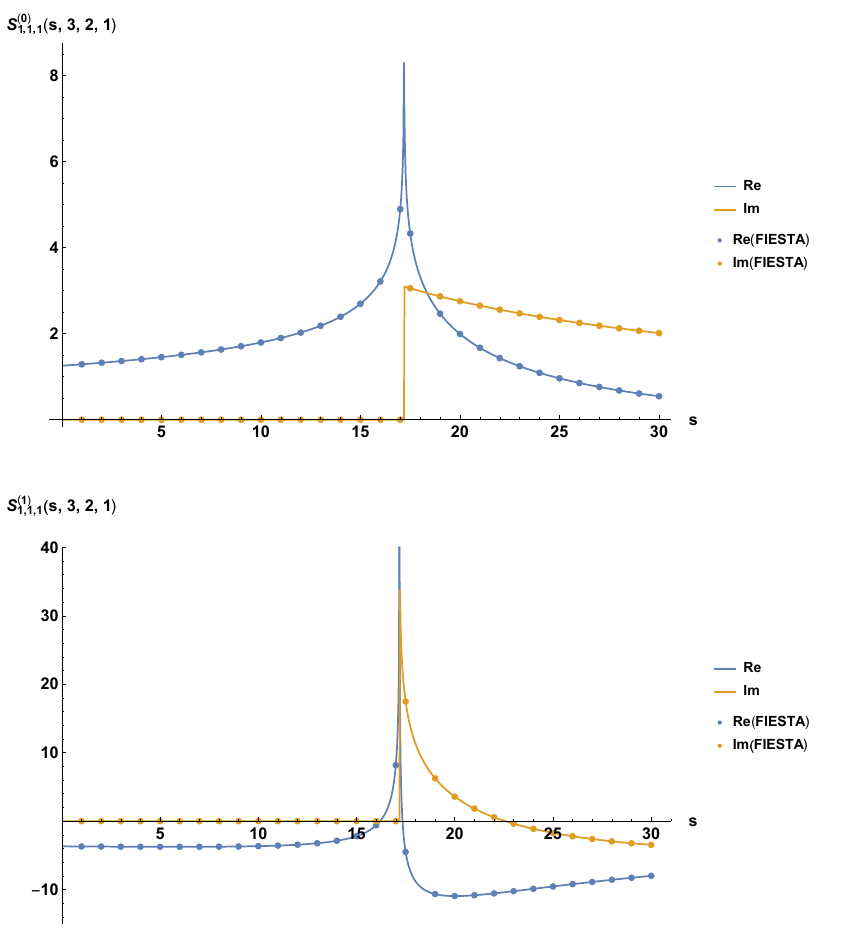
Figure 1 . Plots of the first two epsilon orders of S